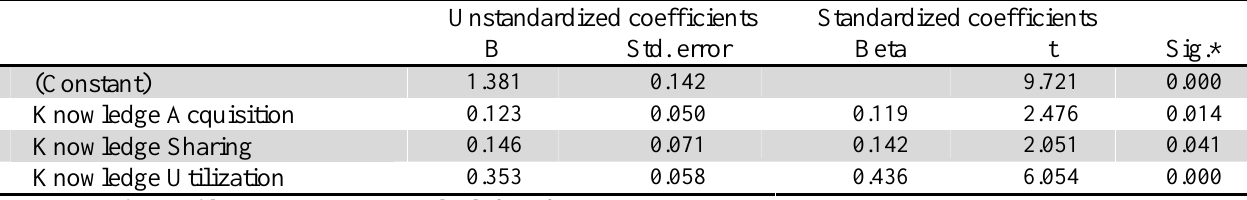
Regression equation- Empowerment and knowledge